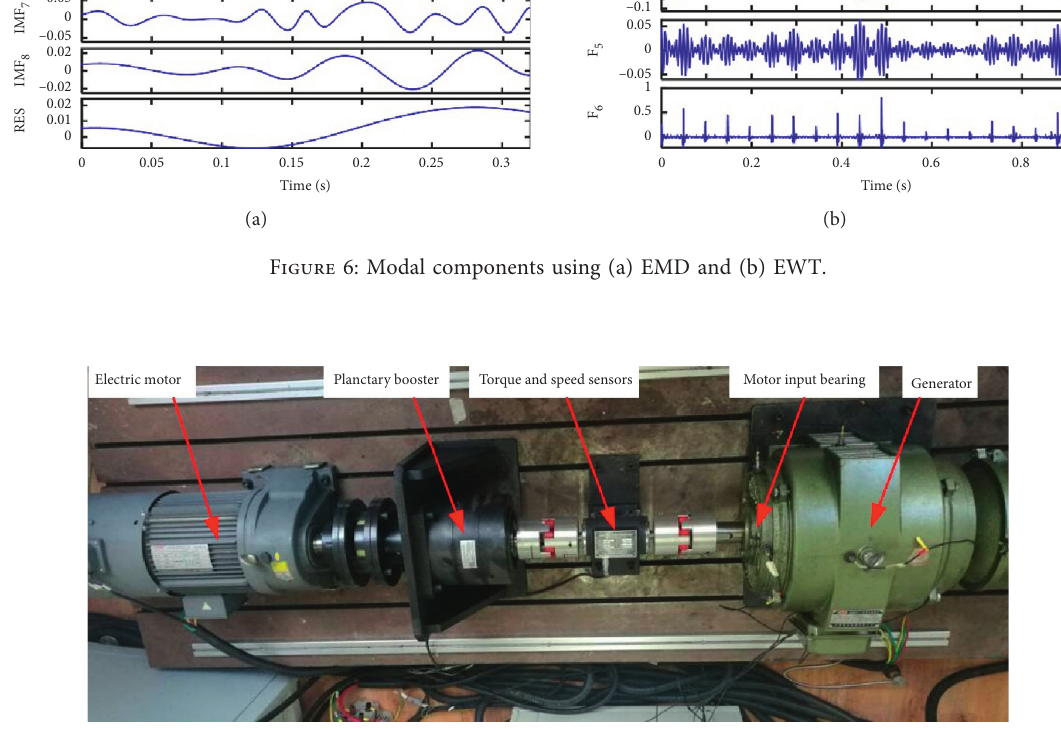
Figure 7: Test bench for testing the failed